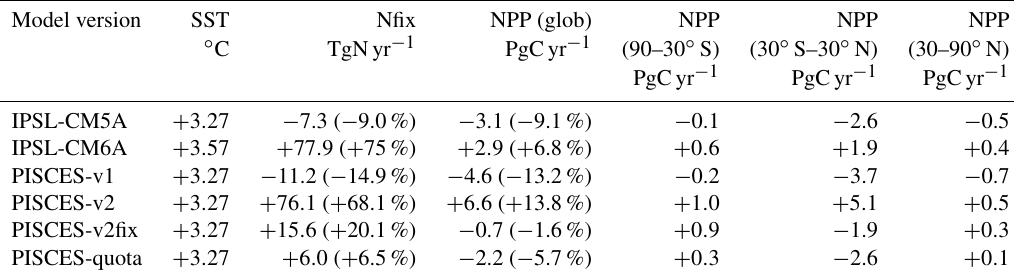
Table 1. Climate change impact on global mean sea surface temperature (SST, ◦ C), depth-integrated N fixation (Nfix, TgNyr − 1 ) and depth- integrated net primary production (NPP, PgCyr − 1 ). All are absolute differences between 2080–2099 and 1986–2005, with relative changes in